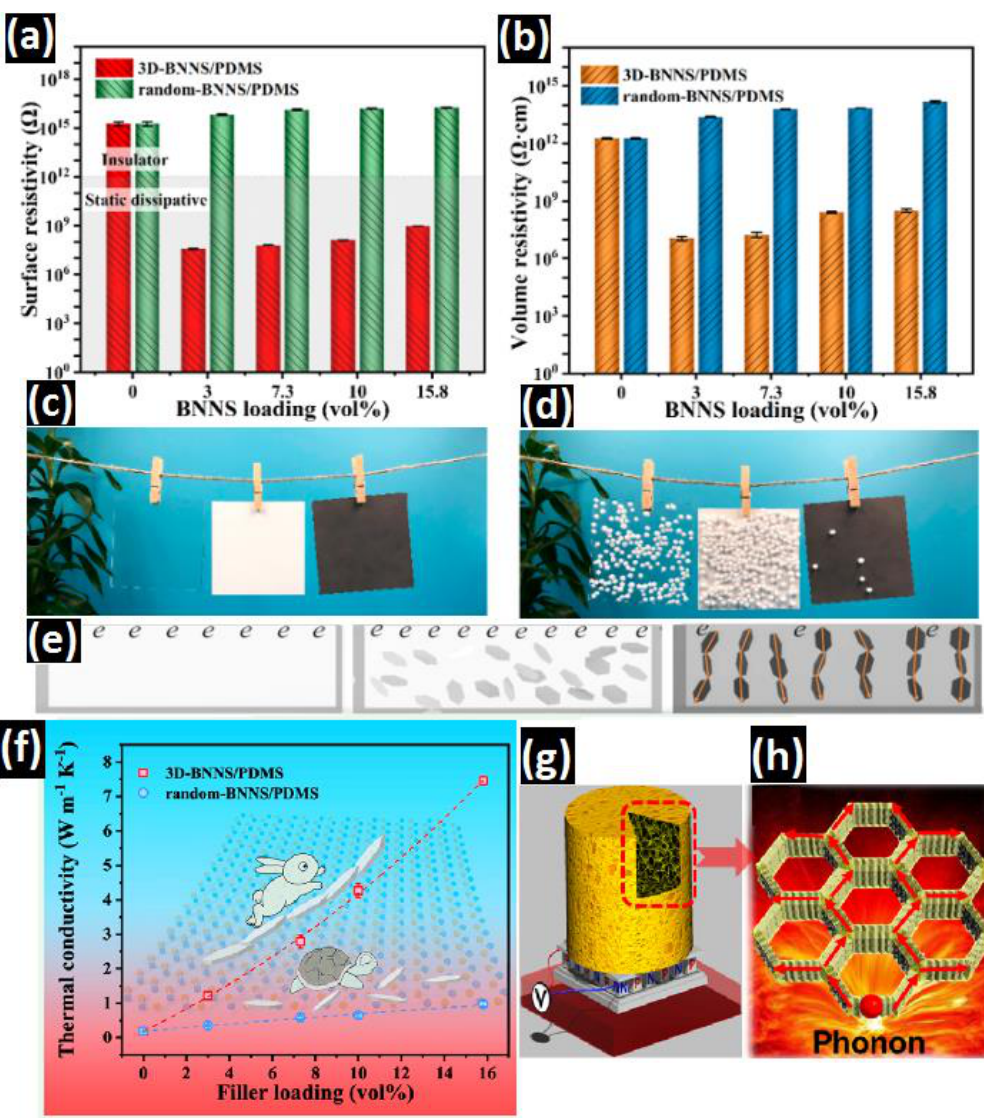
Figure 8. ( a ) Surface resistivity, ( b ) volume resistivity, digital image ( c ) before and ( d ) after electrostatic adsorption of polystyrene spheres, ( e ) schematic diagram of static dissipation of pure PDMS, random BNNSs / PDMS, and 3D-BNNSs / PDMS composites (sample size: 10 cm × 10 cm), ( f ) the comparison of TC value for two BNNSs / PDMS composites with di ff erent structure (Reprinted with permission from American Chemical Society, Copyrights 2019) [53]. Schematic illustration of ( g ) the Aerogel for thermoelectric generator device and ( h ) phonon scattering through the aerogel structure (Reprinted with permission from American Chemical Society, Copyrights 2019) [54].